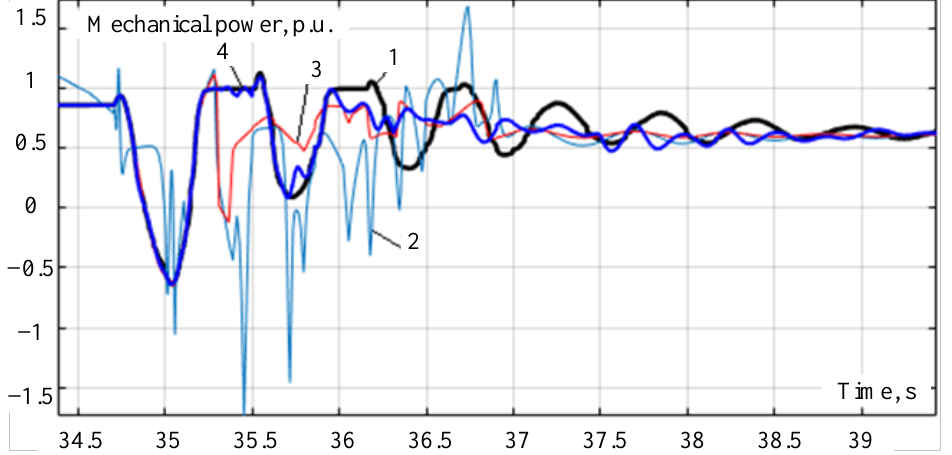
Figure 12. Results of experimental data and fuzzy model response: 1 — experimental data;